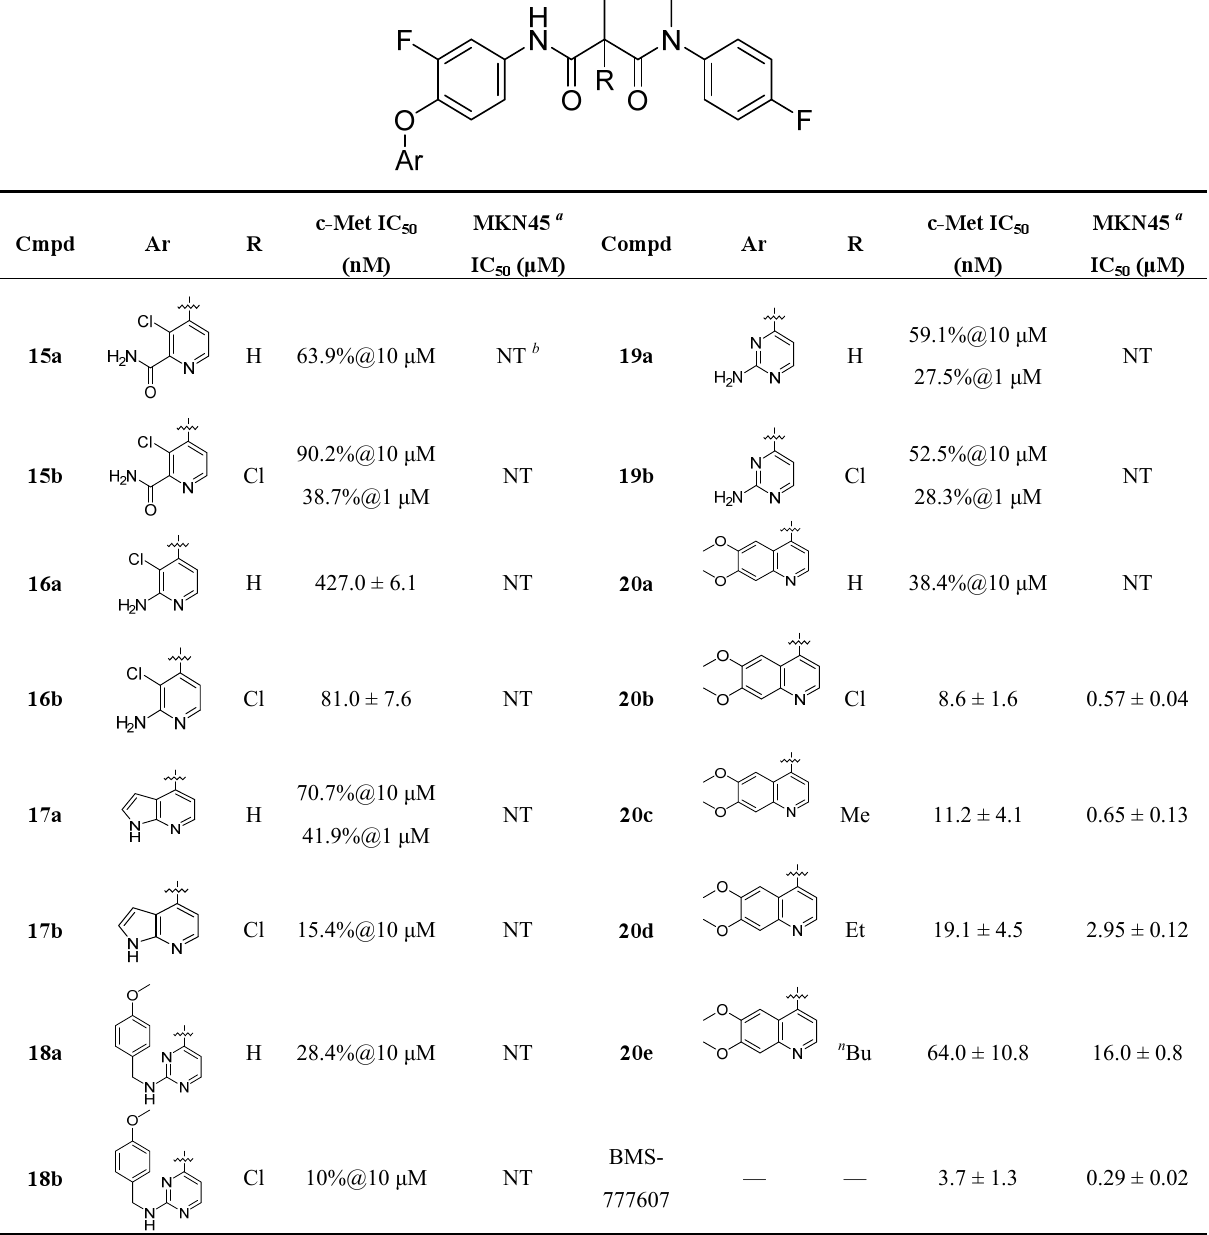
Table 1. SAR of the compounds bearing a 3-carboxypiperidin-2-one